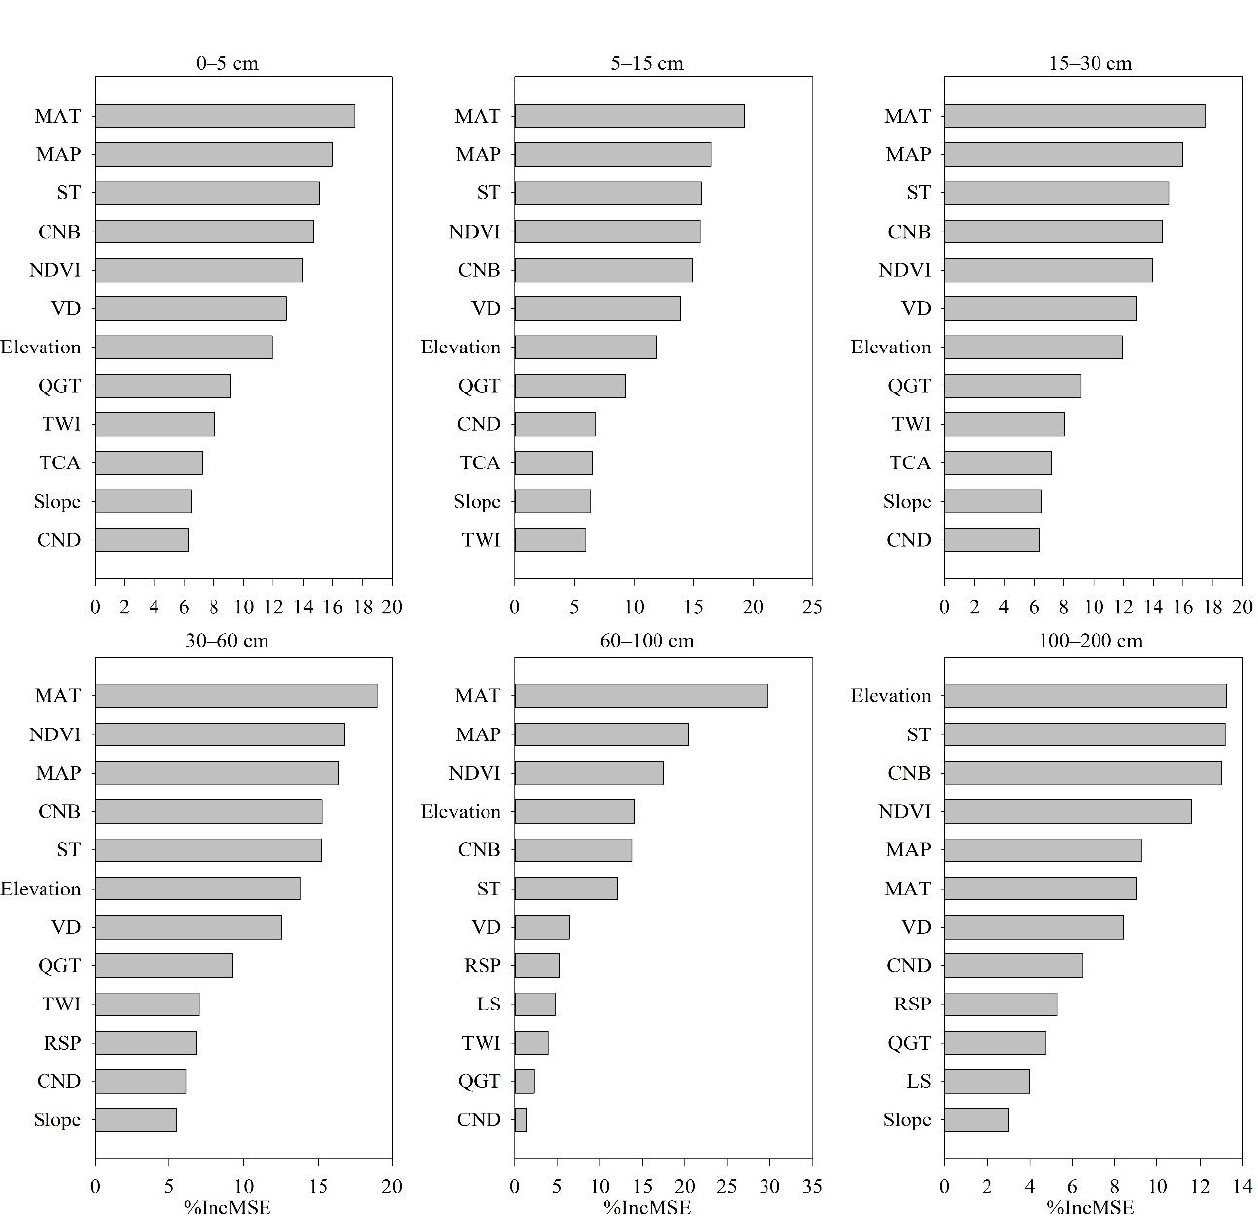
Figure 6. Relative importance (%IncMSE) of the covariates for silt predictions.